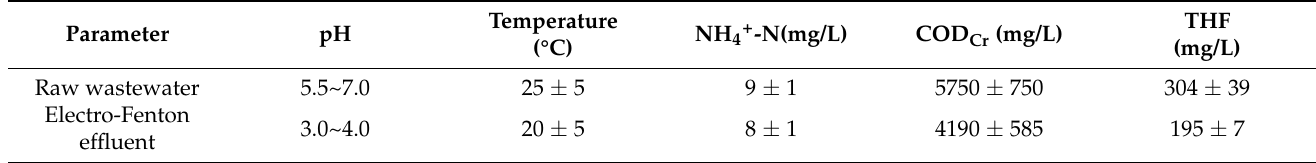
Table 1. Source characteristics of pharmaceutical